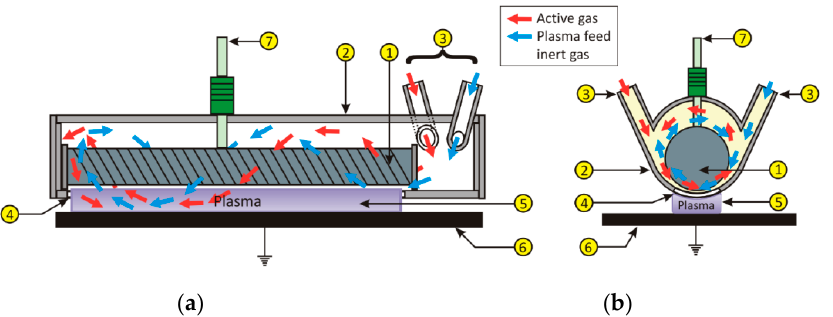
Figure 1. The schematic diagram of our plasma applicator design, ( a ) (left) transversal view and ( b ) (right) axial view. ( b ) (right) axial